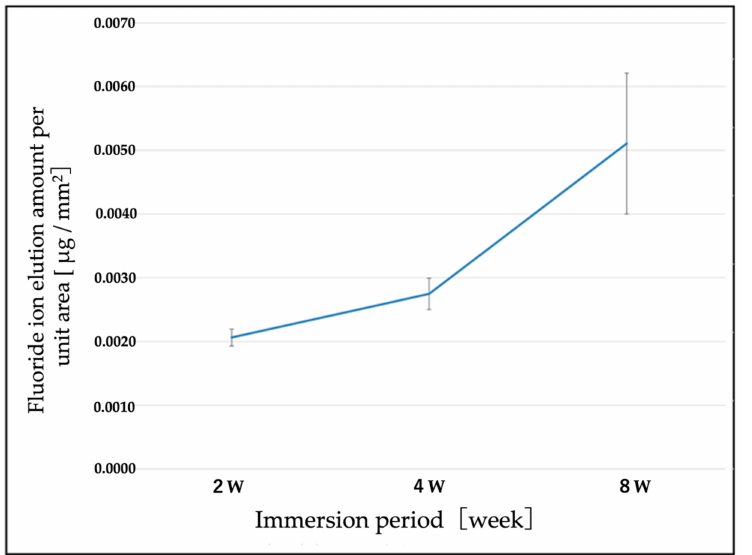
Figure 9. Changes over time in the amount of fluorine elution per unit area. The concentration of F ions tended to increase over